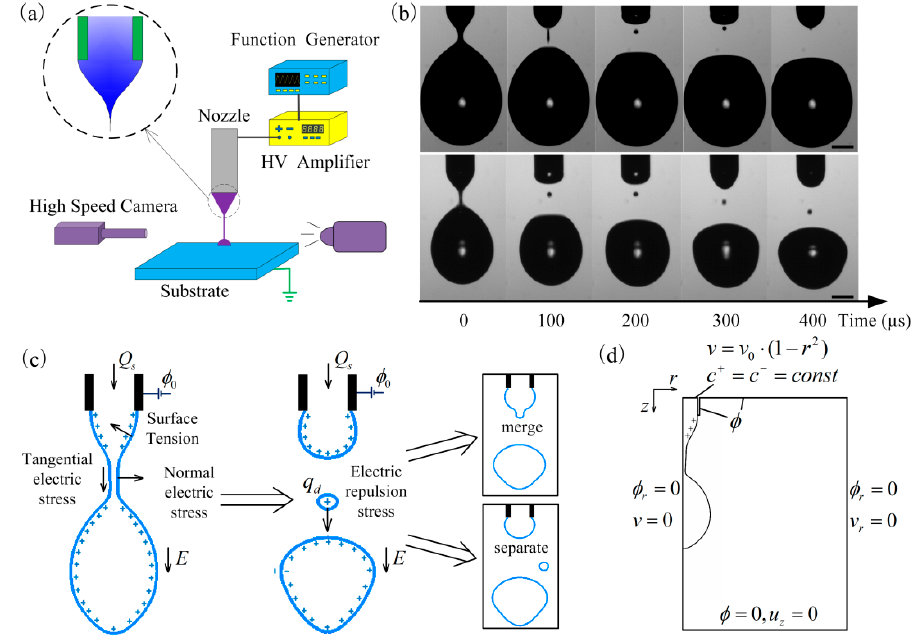
Figure 1. ( a ) The schematic of the experimental setup. ( b ) The two different satellite drop flight behaviors. For the upper images, the liquid was ethanol and the applied voltage was 1350 V. For the lower images, the liquid was a mixture of glycerin and water with the volume ratio of 1:2 and the applied voltage was 2300 V. The nozzle-to-substrate distance was 2.6 mm, which was 20 times the nozzle radius for both experiments. Scale bars: 200 µ m. ( c ) The stress on the surface of the drop during breakup and the stress on the satellite drop during satellite drop motion. ( d ) The simulation domain and the boundary conditions for the simulation.